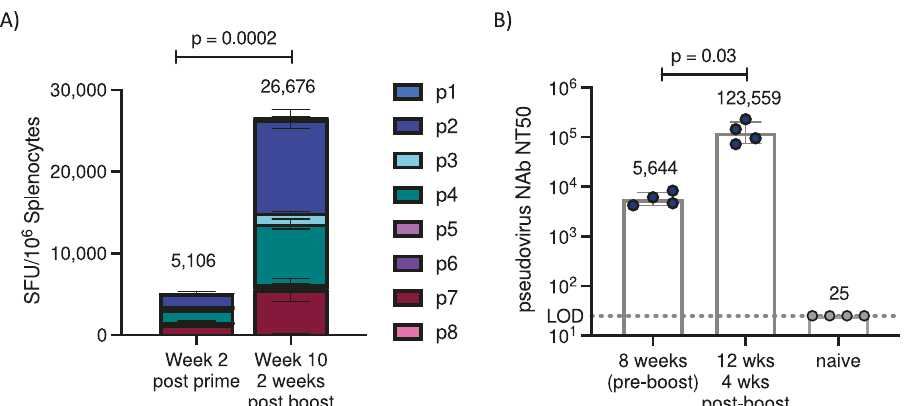
Fig. 2 SAM boost immunization drives increased antigen-speci fi c T cells and neutralizing antibody titers. Mice received SAM Spike(V2)-F2P prime immunization, followed by boost 8 weeks post prime (10 μ g each). N = 4 mice/group. A T-cell response at the speci fi ed timepoint, assessed by IFN γ ELISpot following overnight stimulation with eight peptide pools spanning spike antigen. Mean± SEM for each peptide pool for N = 4 independent animals per group; representative data from one of four similar studies, see additional data in Supplementary Fig. 3. Annotated numbers are the average sum of all eight peptide pools for each animal. Unpaired Student ’ s t-test (two-tailed) comparing sum of pools for each animal at each timepoint. Immunizations for each group were staggered to enable splenocyte collection and measurement of multiple timepoints post immunization in the same assay. B Pseudovirus neutralizing titer (NT50) at the speci fi ed timepoint. Geometric mean and geometric SD of N = 4 mice per group for one experiment. Representative data from one of three similar studies. Sera from Naive mice were below LOD of 25. Two-tailed Mann – Whitney